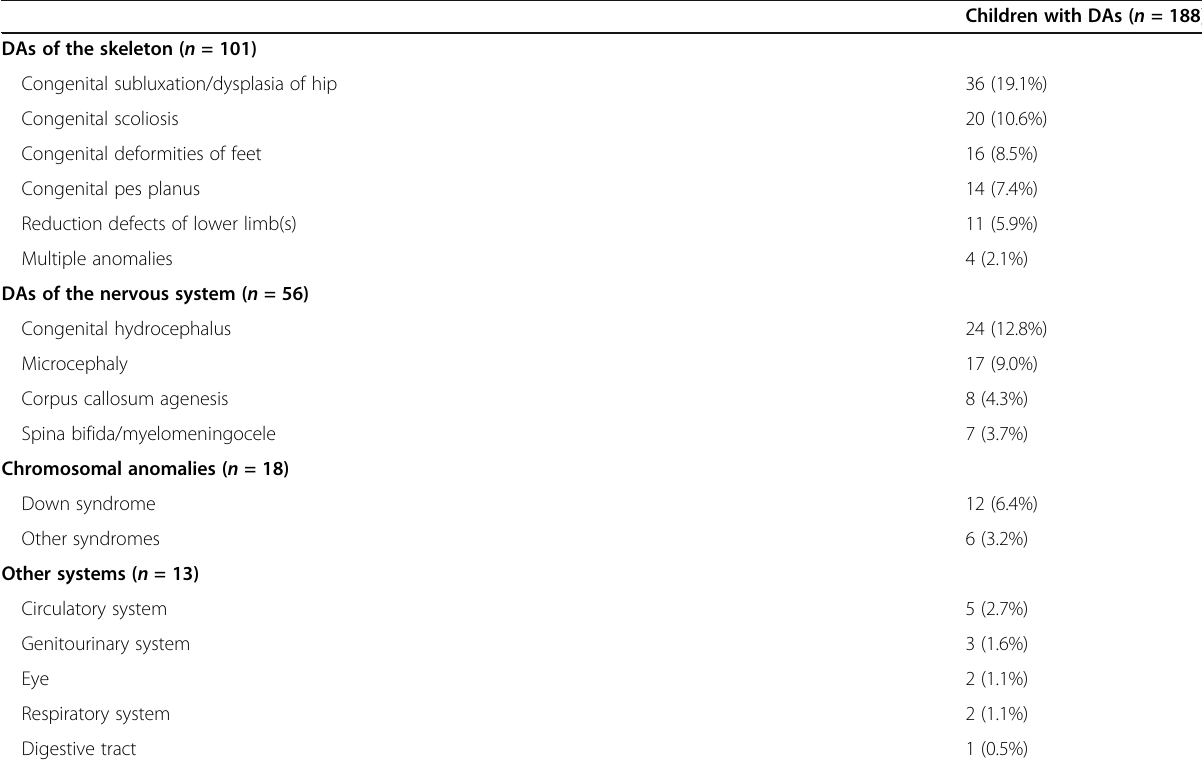
Children with DAs ( n = 188)